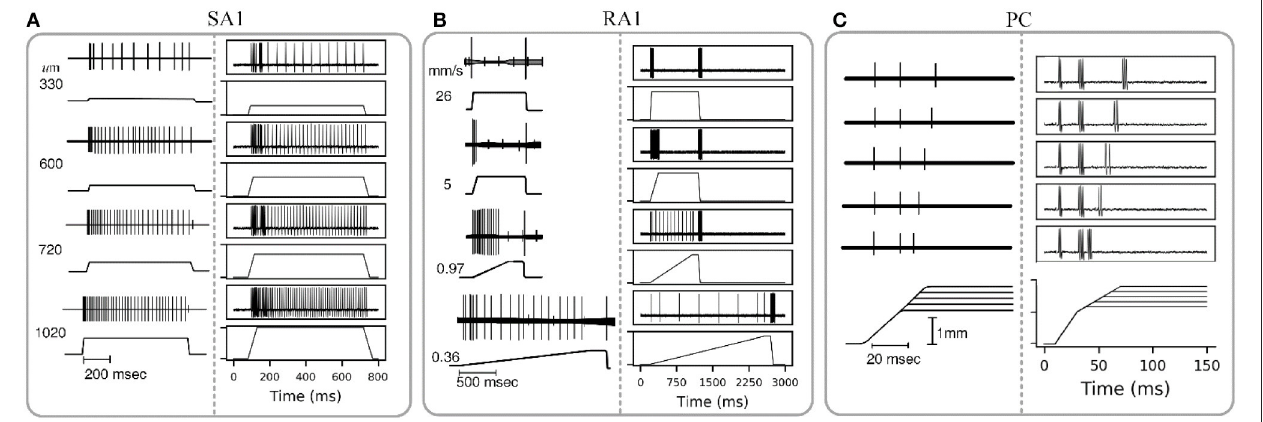
FIGURE 4 | Adaptation properties of different types of tactile units. The recorded data of SA1, RA1, and PC are adapted from Mountcastle et al. (1966), Talbot et al. (1968), and Knibestöl (1973), respectively. (A,B) Recorded (left) and simulated (right) responses of single SA1 unit to ramp-and-hold indentations at different indentation depths, and single RA1 unit to ramps approaching indention of 850 um at different speeds. The stimulus amplitude and time course are shown in the lower trace of each pair; the upper trace shows the action potentials recorded from the sensory nerve fiber in response to the stimulus. (C) Recorded (left) and simulated (right) responses of a PC unit to stimulus with reduction of indentation amplitude. The upper traces show the recorded action potential for five amplitude levels in descending order downwards, and the lower traces show the analog signals of the corresponding stimuli.